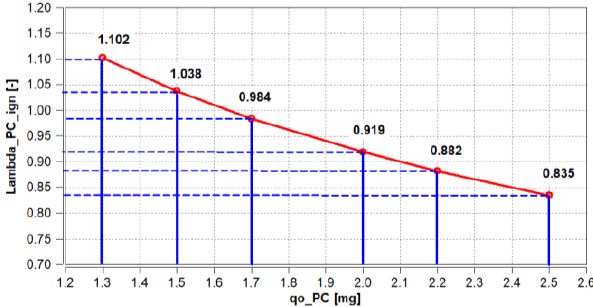
Fig. 3. Combustion chamber: a) mesh with compaction of the prechamber, b) shape of the combustion chamber